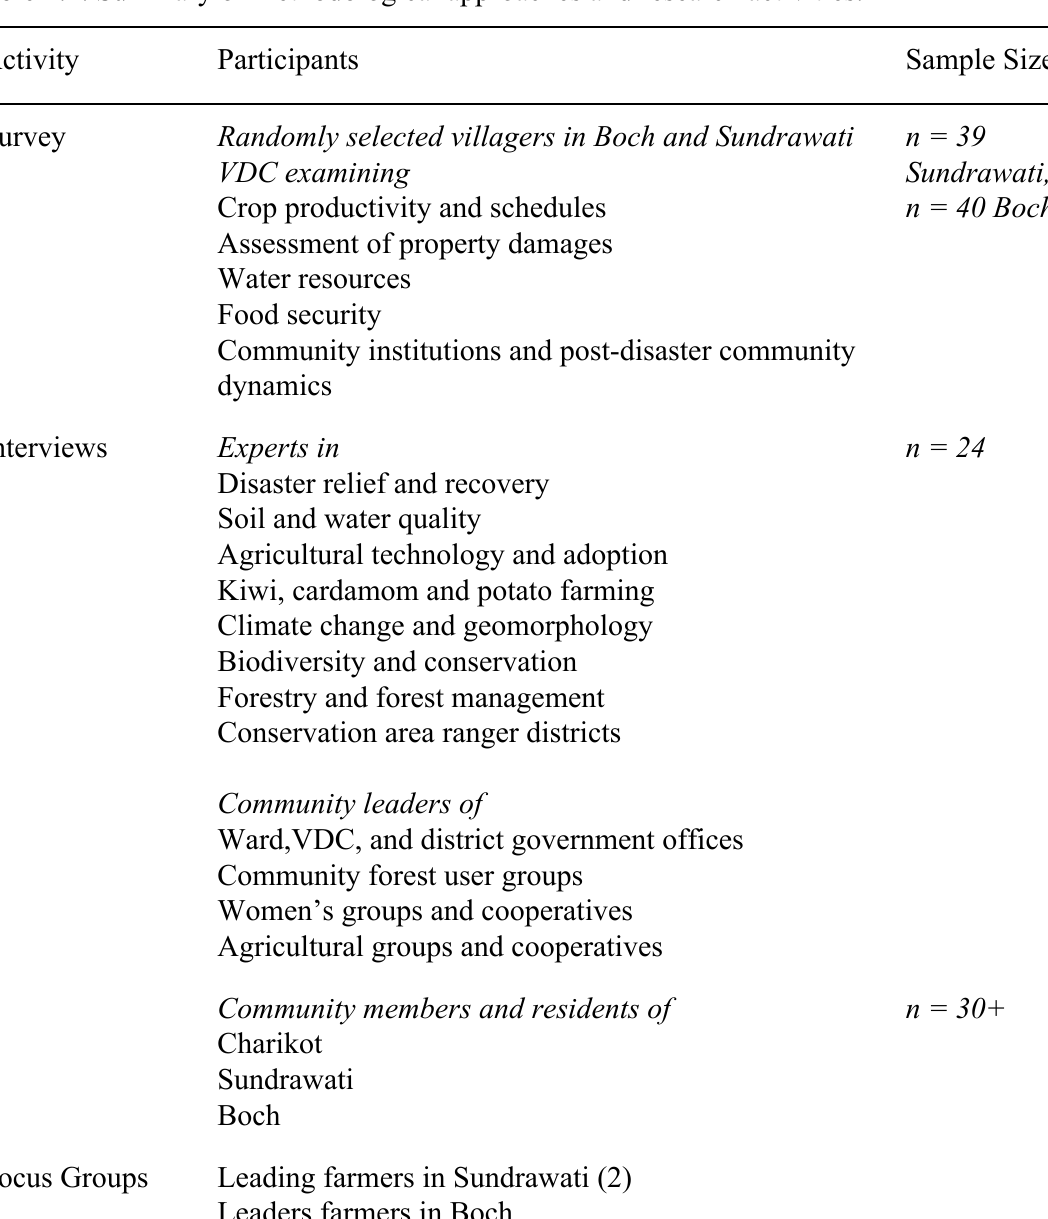
Table 2.1. Summary of methodological approaches and research